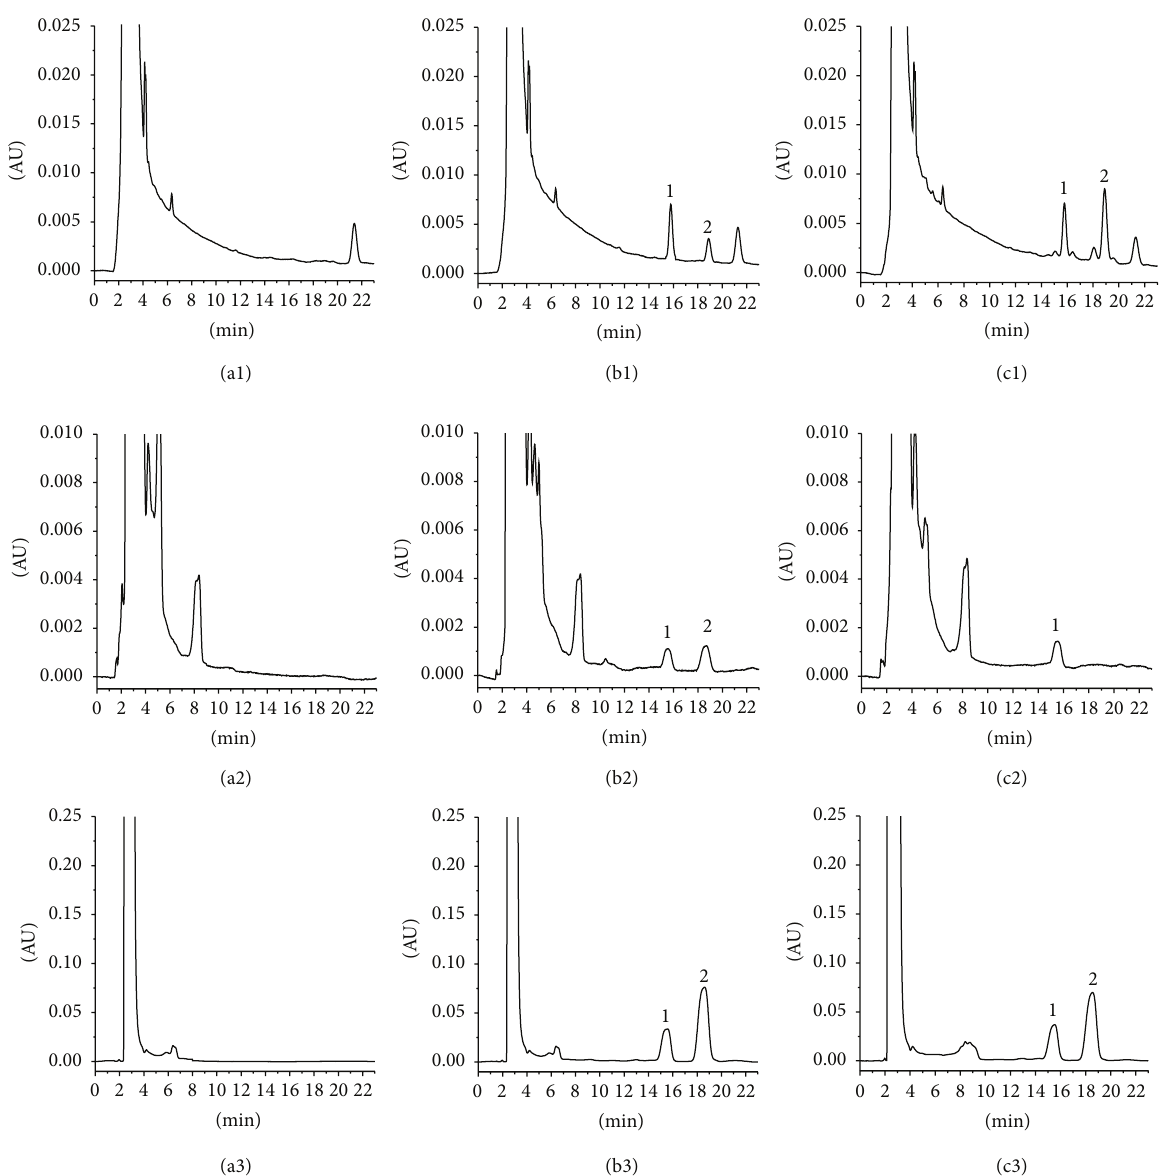
Figure 2: Chromatograms of ergosterol and IS in rat plasma, urine, and faecal homogenate—(a1) blank rat plasma, (a2) blank urine, (a3) blank faecal homogenate, (b1) blank plasma spiked with ergosterol and IS, (b2) blank urine spiked with ergosterol and IS, (b3) blank faecal homogenate spiked with ergosterol and IS, (c1) a rat plasma sample after oral administration, (c2) a urine sample after oral administration, and (c3) a faecal homogenate sample after oral administration (1, IS; 2, ergosterol).